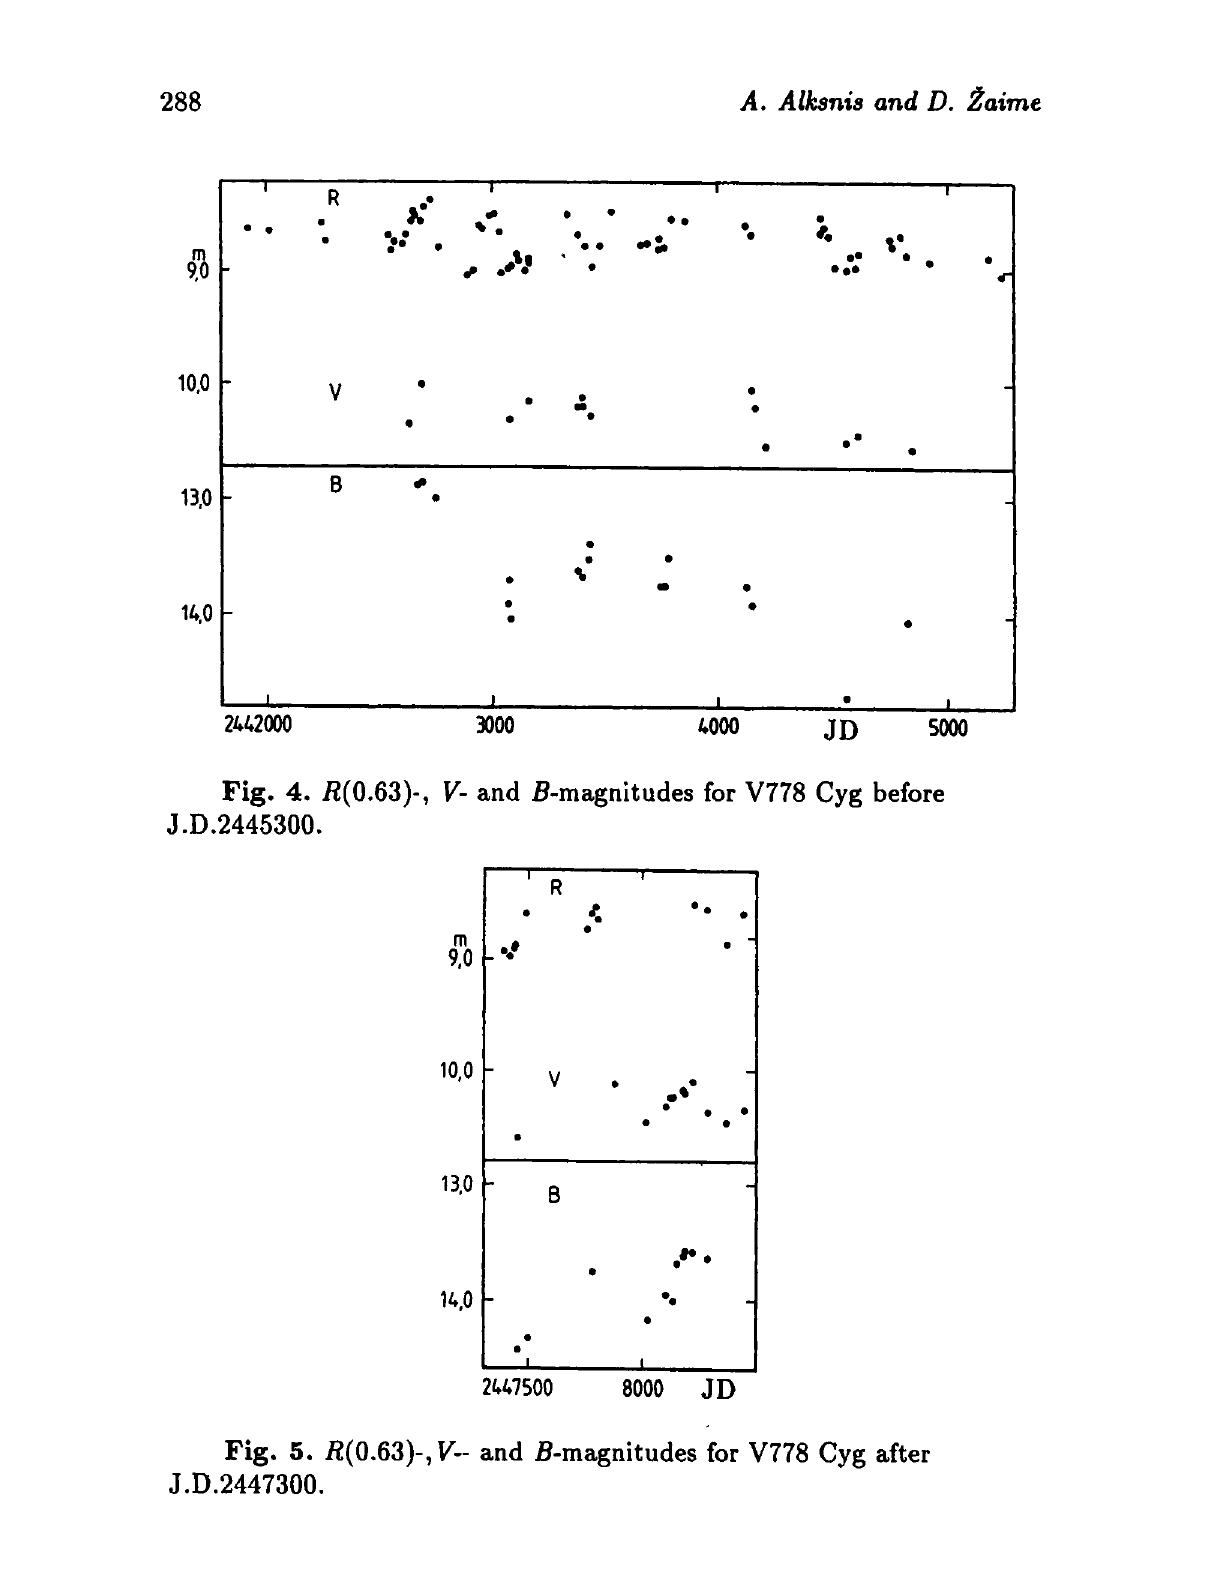
Fig. 5. ß(0.63)-,K- and fl-magnitudes for V778 Cyg after